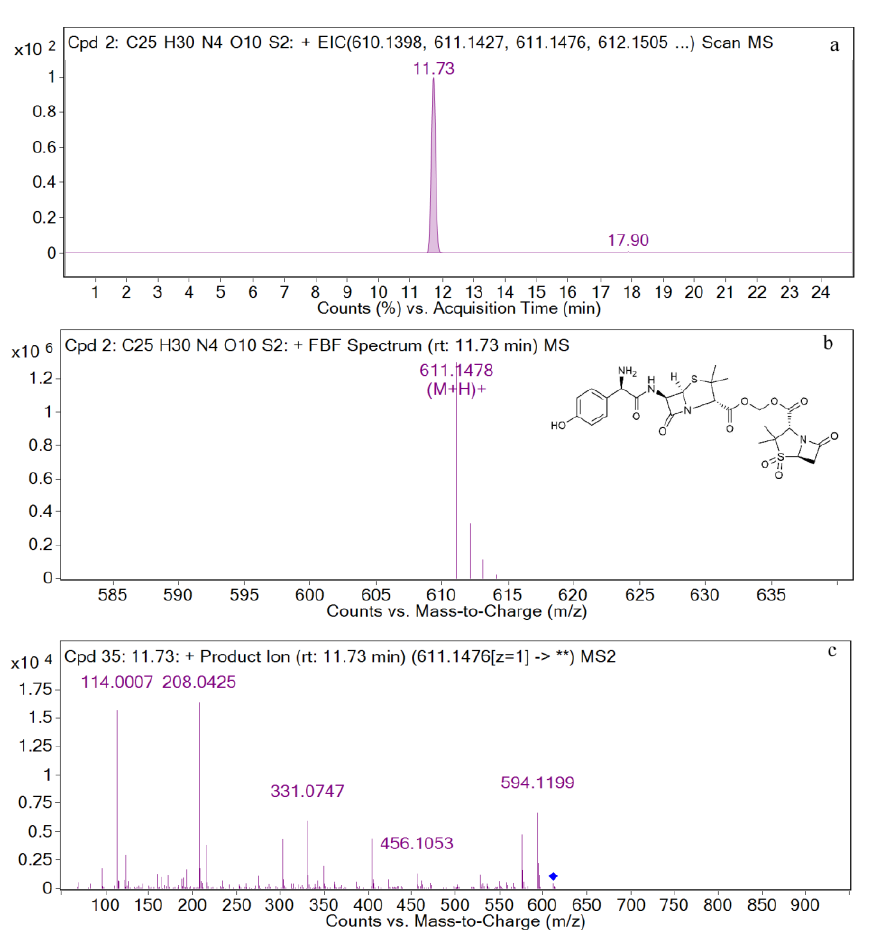
Figure 3. EIC and mass spectrometry results for AS. ( a ) EIC spectrometry results for AS; ( b ) Mass spectrum of AS; ( c ) Two-stage mass spectral data of AS.